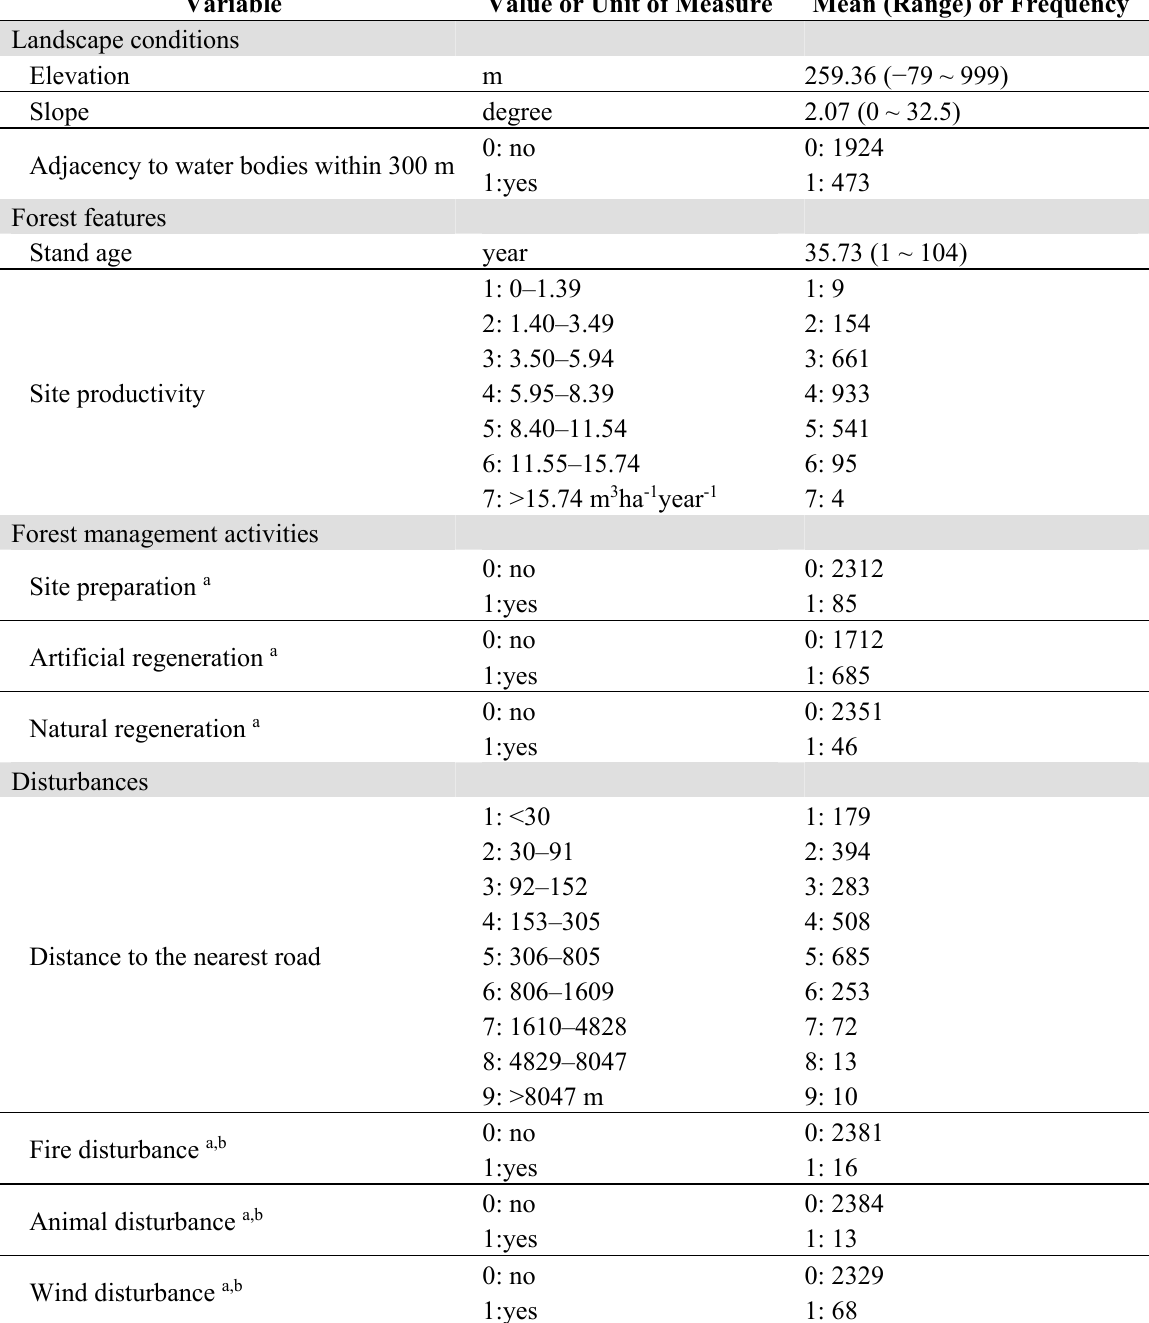
Table 1. Descriptions, values or units of measure, and means or frequencies of climatic conditions, landscape features, forest conditions, and management activities and disturbances evaluated as potential factors of site invasion by Chinese privet in forest plots of Eastern